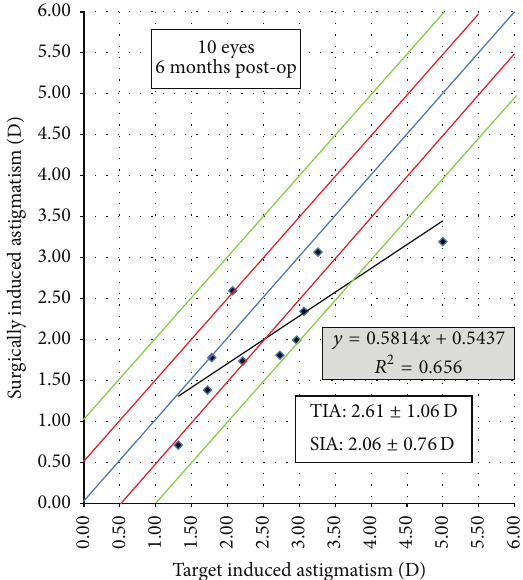
Figure 2: Target induced astigmatism versus surgically induced astigmatism 6 m